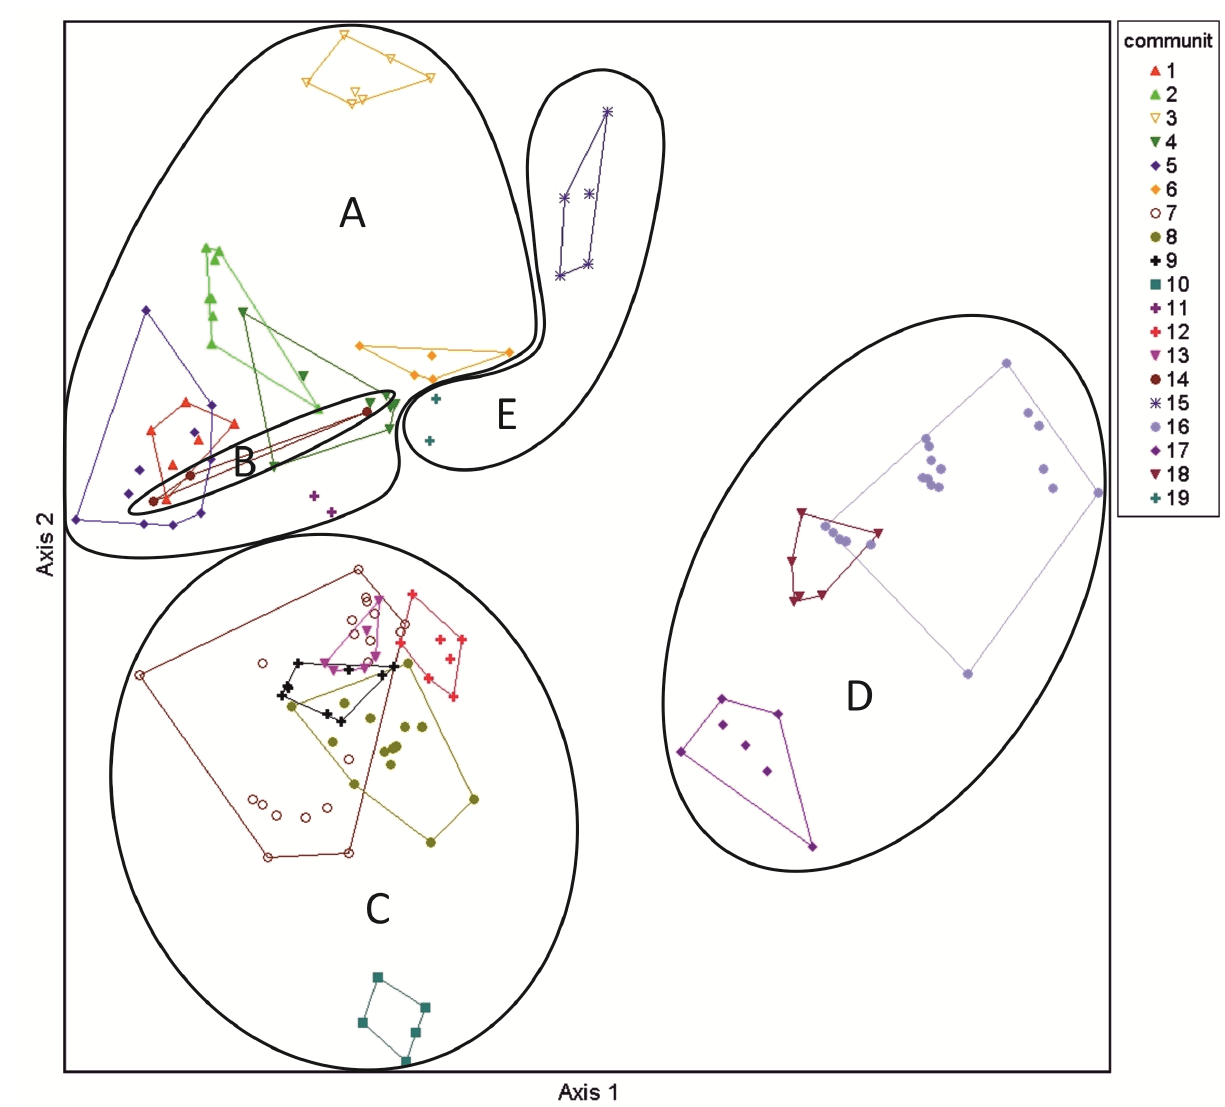
Figure 3. NMDS ordination of relevés, 2D (axis 1-2) representation of single associations and alliances: 1. Isolepido cernuae-Ranunculetum saniculifoliae; 2. Ranunculo ophioglossifolii-Callitrichetum brutiae; 3. Ranunculo ophioglossifolii-Elatinetum alsinastri; 4. Coronopo squamati-Damasonietum polispermi; 5. Ranunculo saniculifolii-Elatinetum macropodae; 6. Pilulario minutae-Isoetetum longissimae; 7. Solenopsio laurentiae-Isoetetum todaroanae; 8 . Poo jubatae-Isoetetum histricis; 9. Solenopsidetum caespitosae; 10. Radiolo linoidis-Solenopsidetum parvulae; 11. Triglochido laxiflorae-Isoetetum longissimae; 12. Anagallido parviflorae- Spergularietum arvensis; 13. Anagallido parviflorae-Molinerielletum minutae; 14. Myosuro minimi-Buillardetm vaillantii; 15. Damasonio alismae-Verbenetum supinae; 16. Phalarido minoris-Agrostidetum